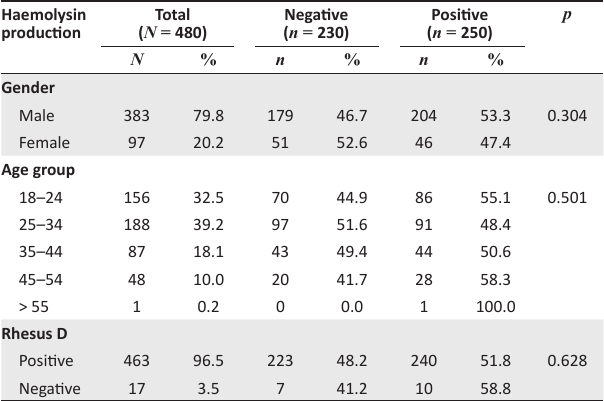
TABLE 1: Association between haemolysin production and gender, age group or Rhesus D positivity of blood group O donors at the RHBBB, Cameroon, June